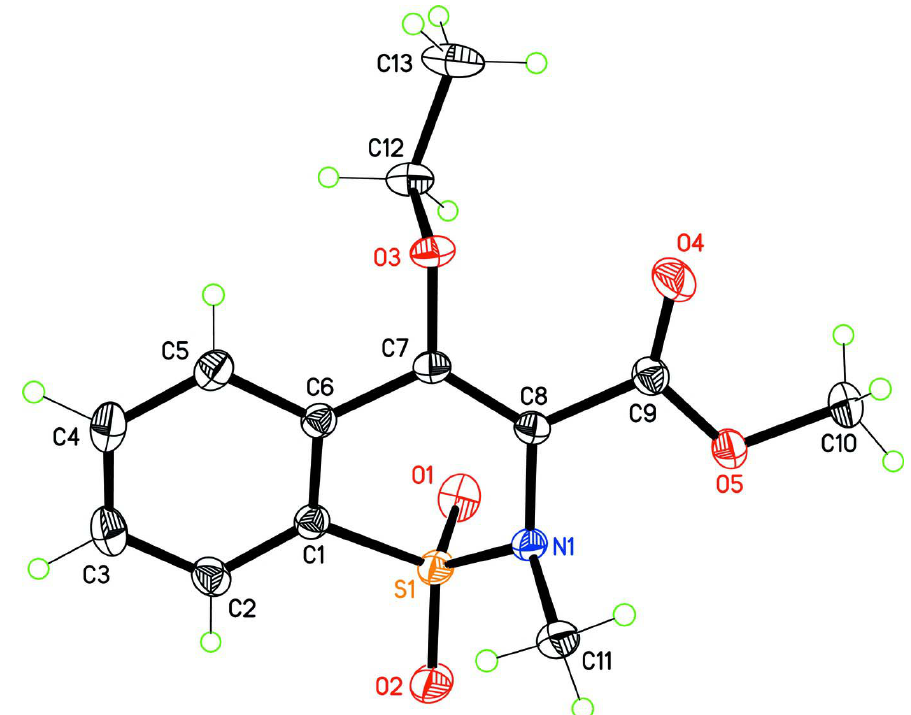
Figure 1 The molecular structure of ( I ), with displacement ellipsoids at the 50% probability